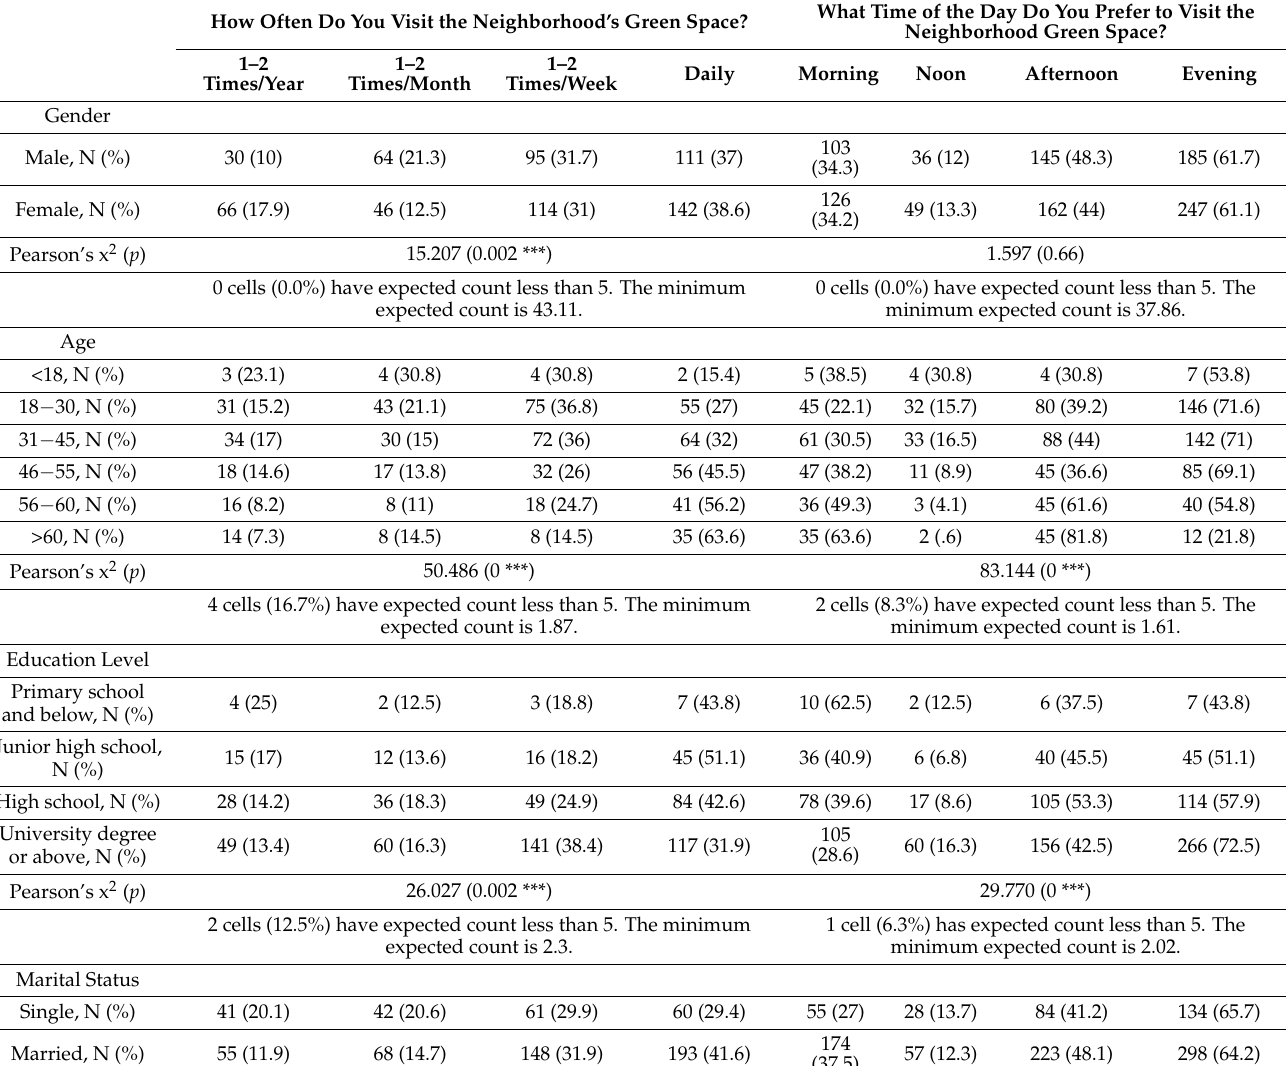
Table 3. User pattern by respondents at an old residential neighborhood’s green space (chi-square and Fisher’s exact test measure x 2 and p